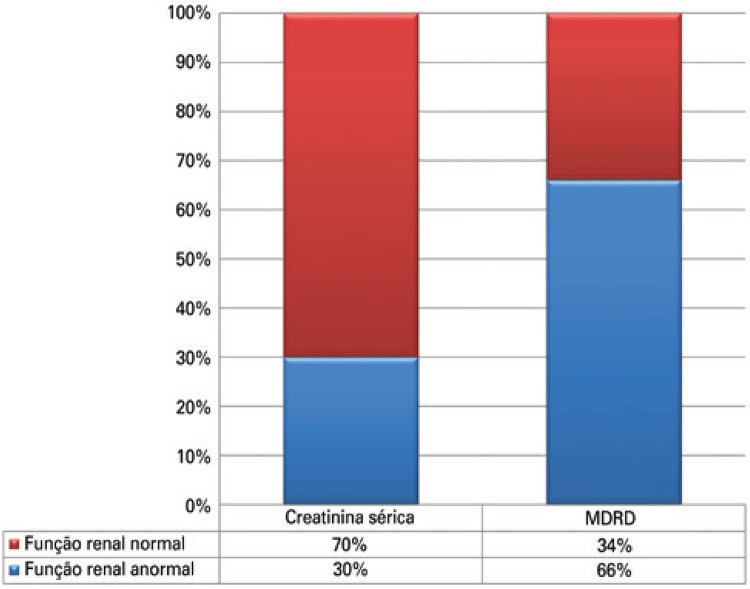
Comparação entre os níveis de creatinina sérica e a fórmula Modification of Diet in Renal Disease